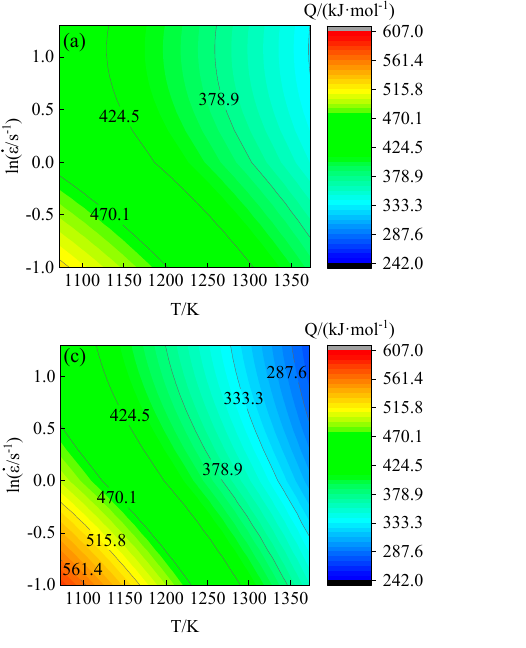
Figure 18. The evolution of activation energy: ( a ) ε = 0.15, ( b ) ε = 0.3, ( c ) ε = 0.45, ( d ) ε = 0.6.